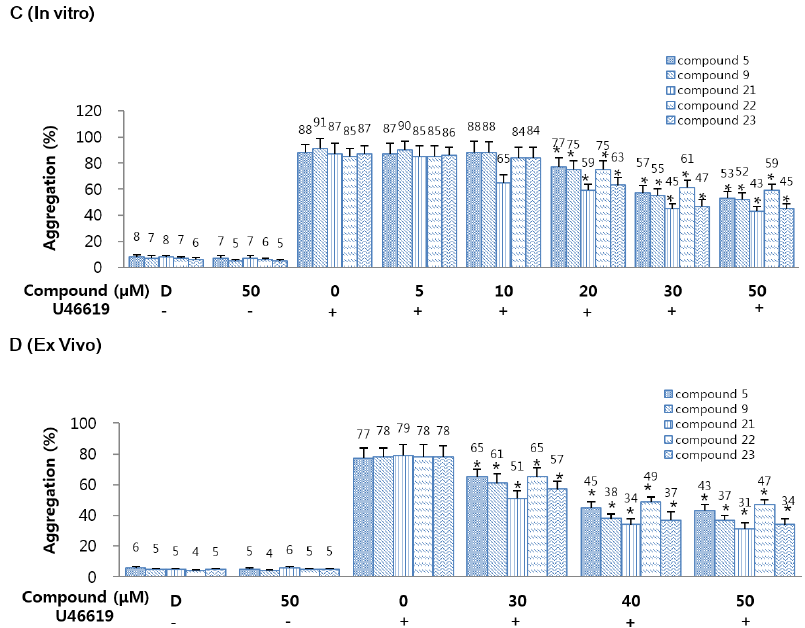
Figure 2. Effects of 5 , 9 , and 21 – 23 on fibrin polymerization in human plasma. ( A ) Thrombin-catalyzed fibrin polymerization at the indicated concentrations of 5 or 9 or 21 – 23 was monitored using a catalytic assay. The results are Vmax values expressed as percentages versus controls; ( B ) The effect of 5 or 9 or 21 – 23 on mouse platelet aggregation induced by 3 U/mL thrombin; ( C ) The effect of each compound on human platelet aggregation induced by 2 mM U46619; ( D ) The indicated concentration of each compound in dimethyl sulfoxide (DMSO) was injected intravenously. The effects of each compound on mouse platelet aggregation induced by 2 µ M U46619 were monitored ex vivo. D: 0.2% DMSO. Data represent the mean ± SEM of three independent experiments performed. * p < 0.05.